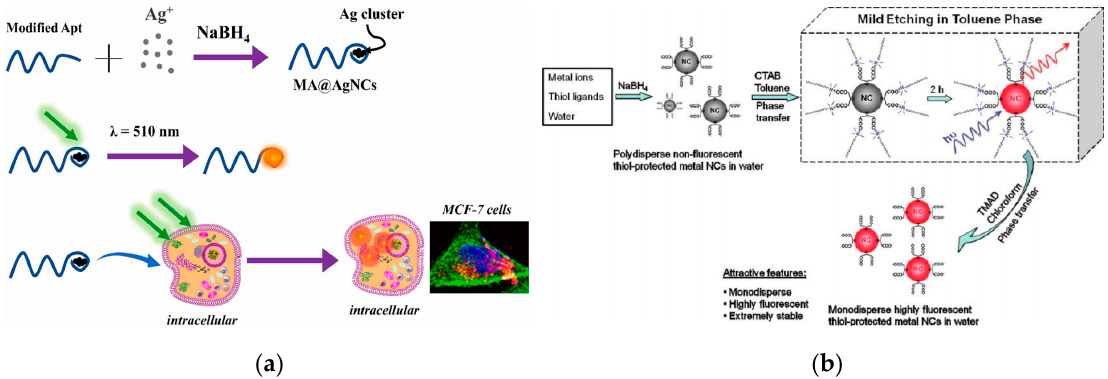
Figure 6 . ( a ) Scheme of modified aptamer@AgNCs synthesis process and application on fluorescence cell imaging. Reproduced with permission from [86]. Copyright Talanta, 2019. ( b ) Scheme of the process to generate highly fluorescent metal NCs by reversible phase transfer. Reproduced with permission from [92]. Copyright ACS Nano, 2011.